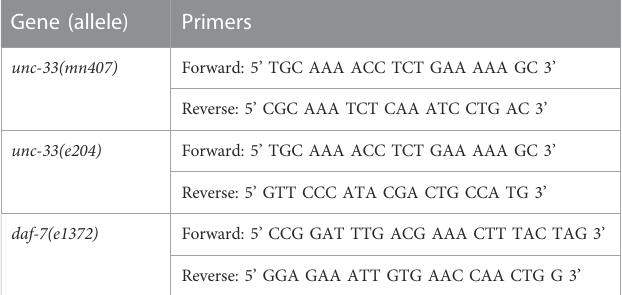
TABLE 1 Gene speci fi c primers used for genotyping. Gene